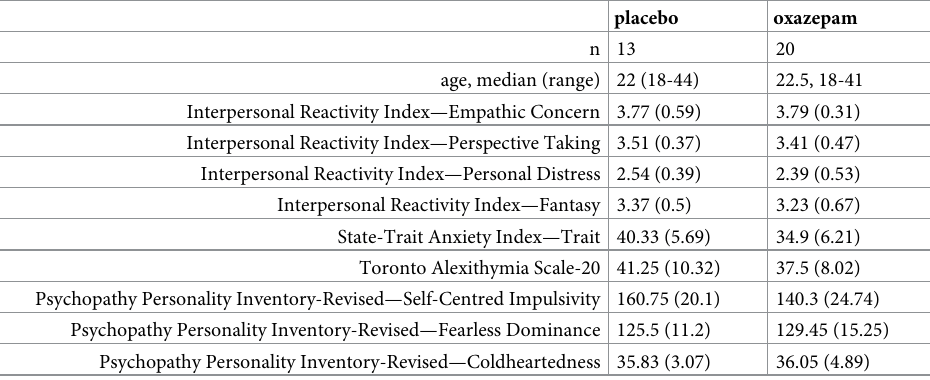
Table 1. Participant